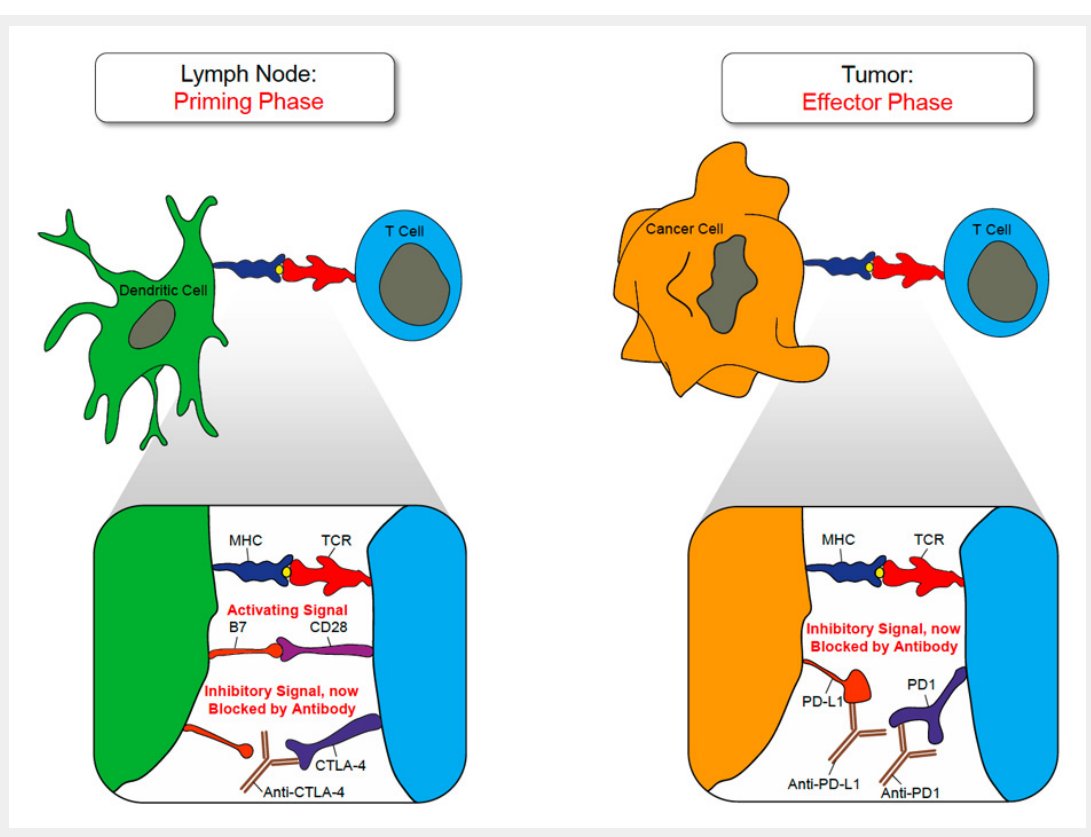
Figure 1 Blockade of CTLA-4 or PD-1 signalling in anti-cancer immunotherapy: The T cell priming phase is schematically depicted on the left site. T cells engage APCs, such as DCs via their TCR. Recognition of the cognate MHC/peptide complex by the TCR results in the intracellular transmission of an activating signal in the T cell, which is complemented by a co- activating signal provided by the CD28/B7 interaction. In order to down-modulate T cell priming and expansion CTLA-4 is up regulated on activated T cells after 2–3 days and competes with CD28 for B7. CTLA-4 blocking antibodies can therapeutically inhibit the co-inhibitory signal provided by CTLA-4. On the right site the effector phase is outlined. During this phase immune effector function can be dampened by PD-1/PD-L1 interaction. PD-1 or PD-L1 blocking antibodies can therapeutically inhibit the co-inhibitory signal provided by the PD-1/PD-L1 interaction and restore effector function in tumour resident effector T